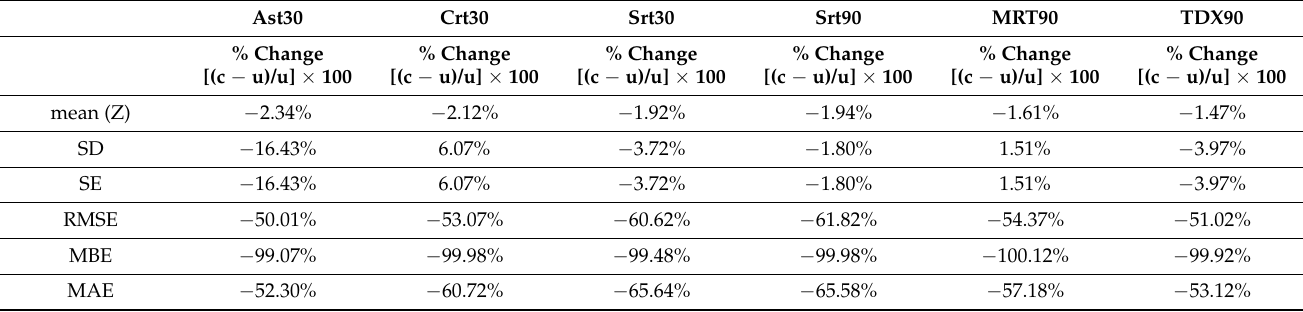
Table 7. Bias (DEM—DGPS) for space-based elevation data (for both uncorrected (u) and corrected (c) elevation) sampled over GCPs. The ground-based DGPS data were used for the calculation of bias. The elevation values were derived from DEMs using the three interpolation methods (DEM resampling), that is, nearest neighbour (nn), bilinear (bl), and bicubic (bc). Bias (DEM-DGPS) for Bias (DEM-DGPS) for Uncorrected “u” Data Corrected “c”